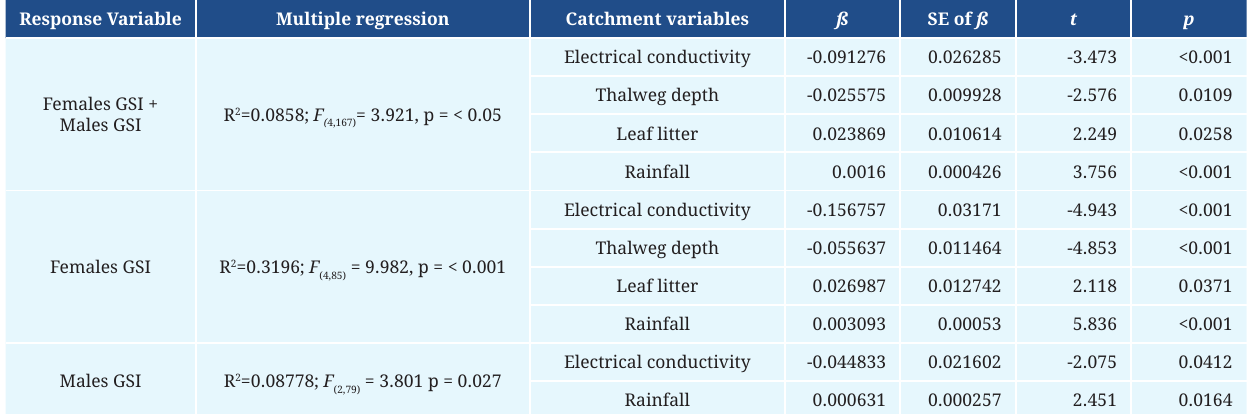
TABLE 2 | Results of multiple regressions between the GSI of the females and males Helogenes marmoratus and the environmental variables recorded in seven streams of a catchment of the Guamá River in Capitão Poço, Pará State,